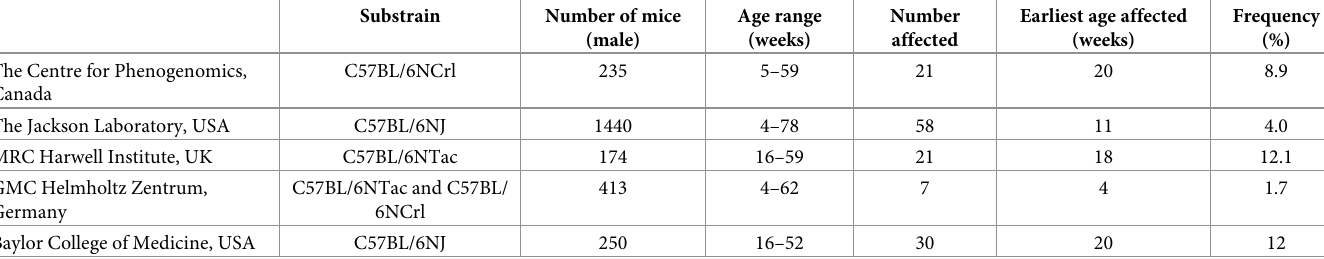
Table 1. The frequency of occurrence of tarsal injuries in C57BL/6N males housed in social